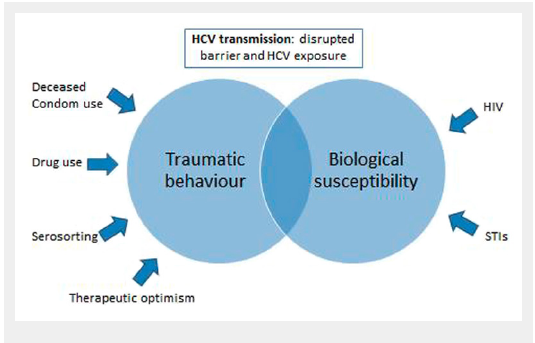
Figure 2 Factors associated with the transmission of HCV in HIV-infected MSM (adapted from Danta et al.